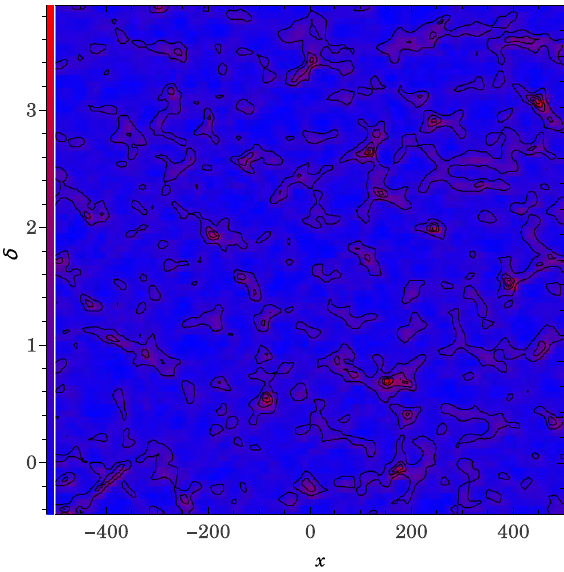
Fig. 3 The distribution of δ( x i ) without tensor perturbations (left) and with tensor perturbations (right) at a S = 1090 and 160 3 resolution. It’s hardtodistinguishtheeffectsoftensorperturbationsfromthemdirectly.